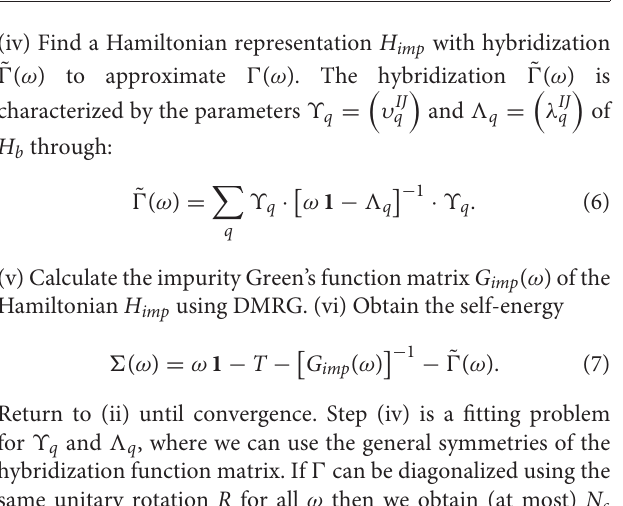
J while the black lines 6=